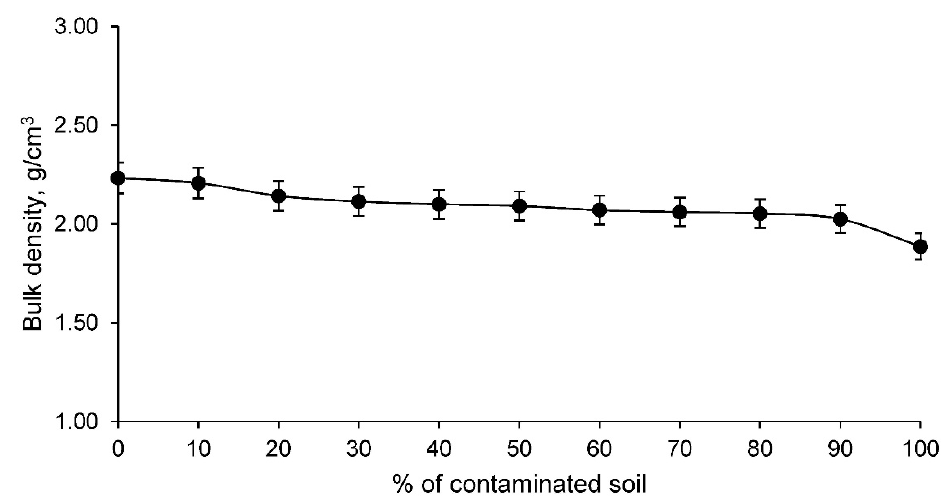
Figure 7. Bulk density of the families of ceramics conforming with various percentages of clay and contaminated soil.